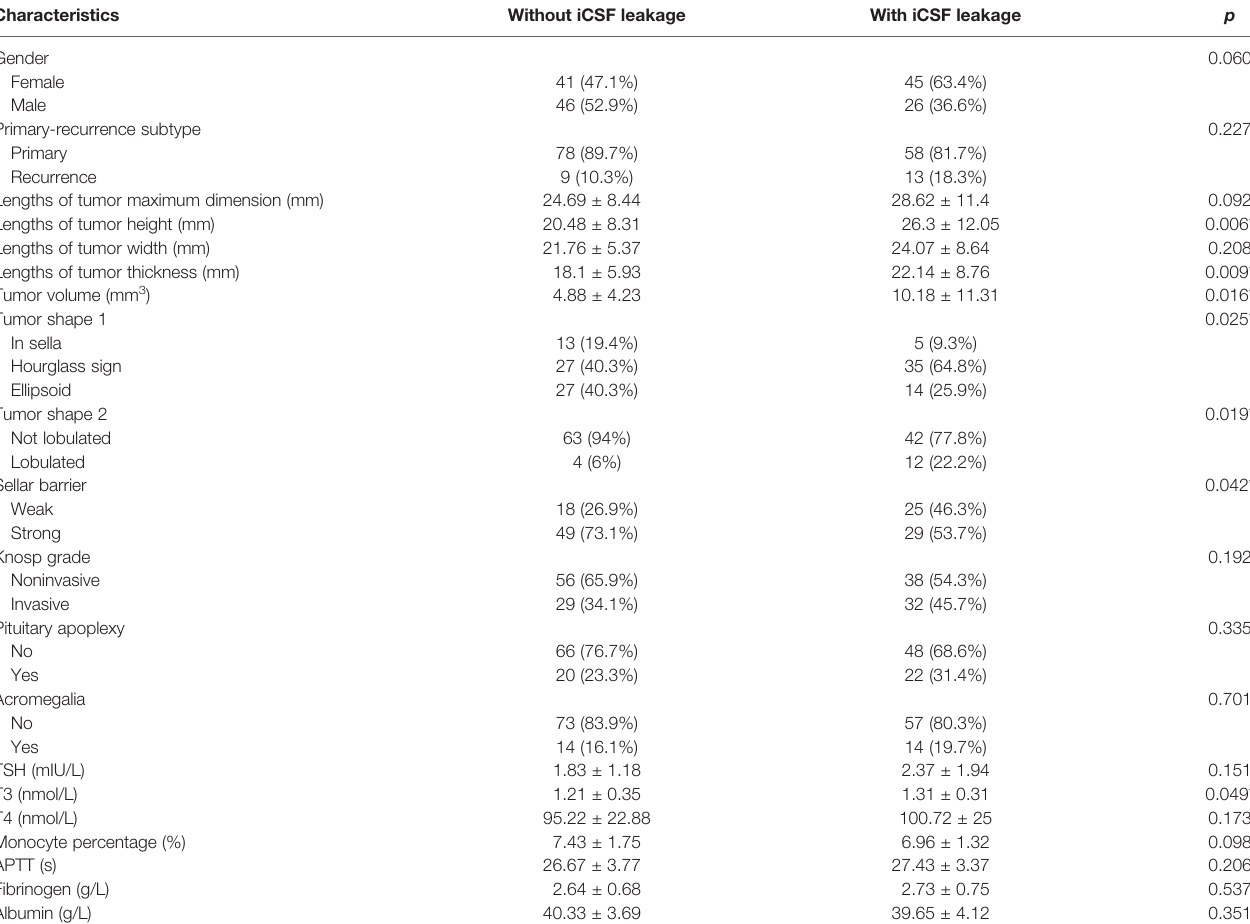
TABLE 1 | Important characteristics of patients in the without iCSF leakage group and in the with iCSF leakage group.